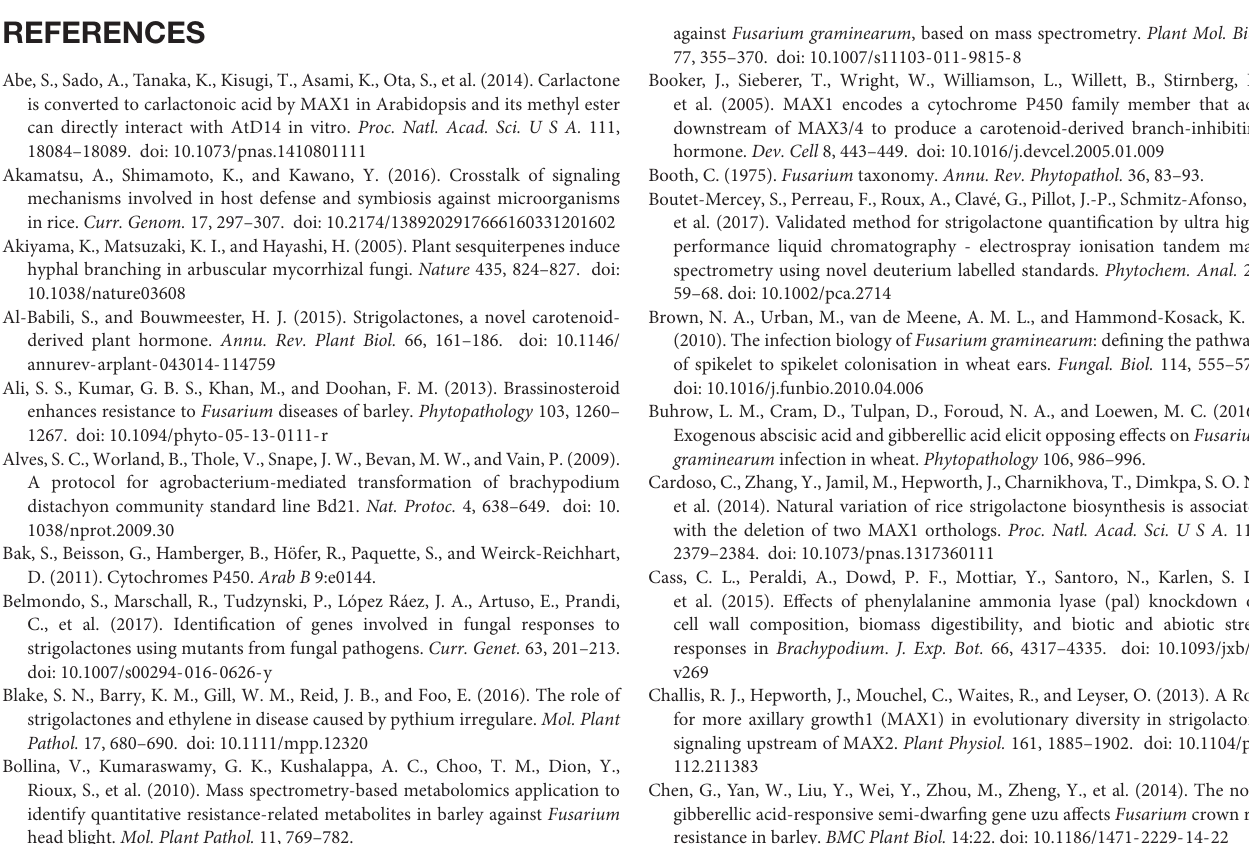
Supplementary Table 2 | List of primers used in qPCR experiments. Supplementary Table 3 | List of characteristic parent and product ions detected during multiple reaction monitoring (MRM) in B. distachyon (Bd21-3) exudates. Supplementary Table 4 | Pairwise distances matrix of of CYP711As from B. distachyon, H. vulgare, O. sativa, A. thaliana and S. moellendorffii . At: A.